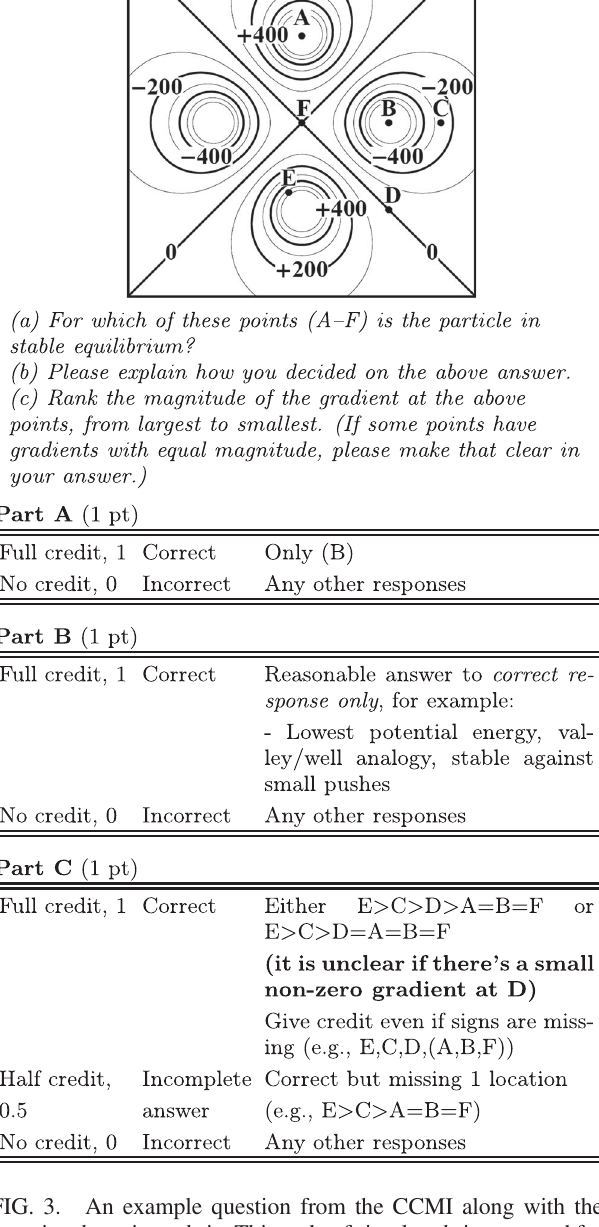
FIG. 3. An example question from the CCMI along with the associated scoring rubric. This style of simple rubric was used for the CCMI and CURrENT and graders need minimal training to produce reliable